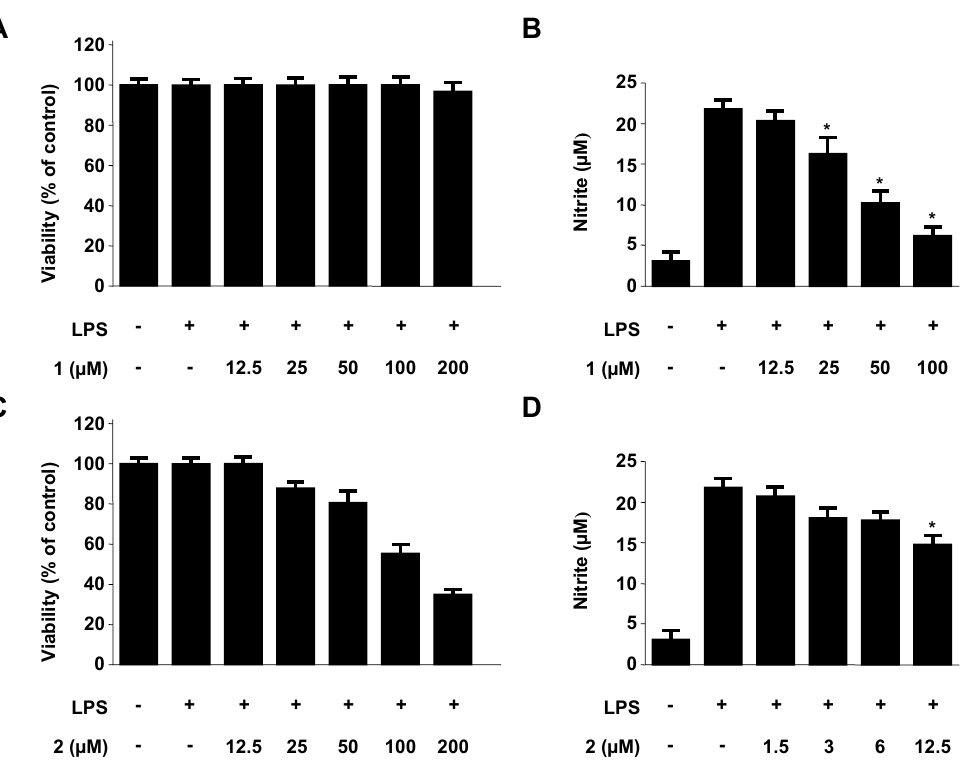
Figure 2. Effects of neoechinulins A ( 1 ) and B ( 2 ) on cell viability (A, C) and nitrite production (B, D). In the cell viability assay, RAW264.7 macrophages were incubated for 24 h with various concentrations (12.5 μ M–200 μ M) of neoechinulins A ( 1 ) and B ( 2 ). Cell viability was determined, as described in the materials and methods. In the nitrite production assay, RAW264.7 macrophages were pre-treated with indicated concentrations of neoechinulins A ( 1 ) and B ( 2 ) for 3 h, and then stimulated with LPS (1 μ g/mL) for 18 h. The concentration of nitrite was determined as described in the Experimental. Data shown represent the mean values of three experiments ± SD. * p < 0.05 as compared to the group treated with LPS